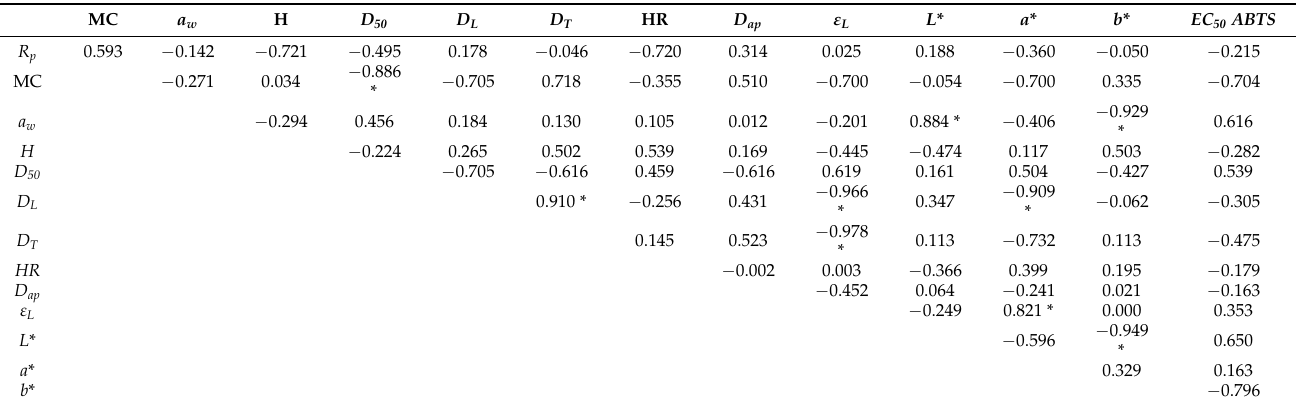
Table A1. Pearson correlation coefficients of between powder recovery ( R p ) and physiochemical properties of buckwheat honey powders obtained by high temperature traditional spray drying (SD) and low temperature spray drying with the application of dehumidified air (DASD) with maltodextrin (MD) and milk powder (MP) as a carrier, containing 50–75% honey